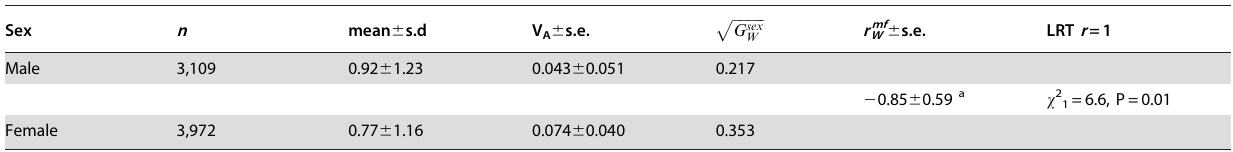
The estimate of additive genetic variance V A , the genetic correlation between the sexes and their standard errors are derived from an animal model, correcting for differences in the ‘cohorts’ (year of first breeding) and study plots. Test of the significance of estimates are based on a Likelihood Ratio Test (LRT) comparison of the likelihood of the full model with a model where the genetic correlation is specified, based on (a) setting the genetic covariance to zero (LRT r =0), and setting the intersexual genetic correlation to + 1 (LRT r =1). The coefficient of additive genetic variation is indicated as ffiffiffiffiffiffiffiffiffi G sex W